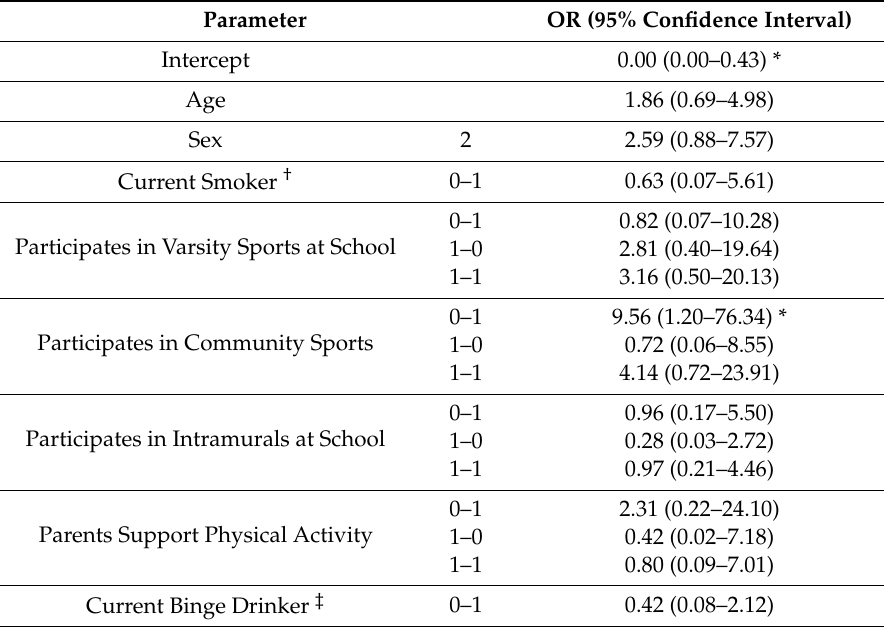
Table 3. Factors associated with meeting the 24-Hour Movement Guideline (24-MG) within the longitudinal COMPASS Year 2 to Year 5 student sample.